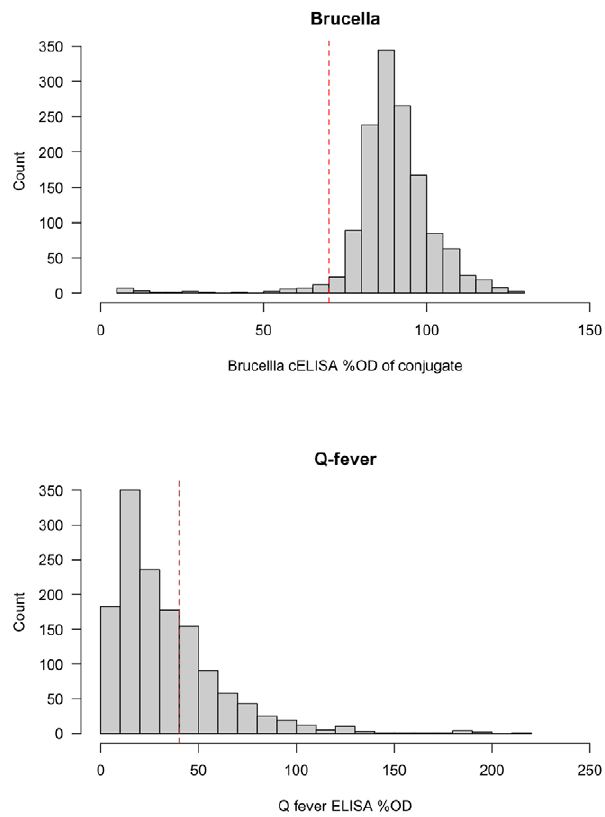
Figure 2. Histogram of optical density values (OD) for the Brucella cELSIA and Q fever ELISA.